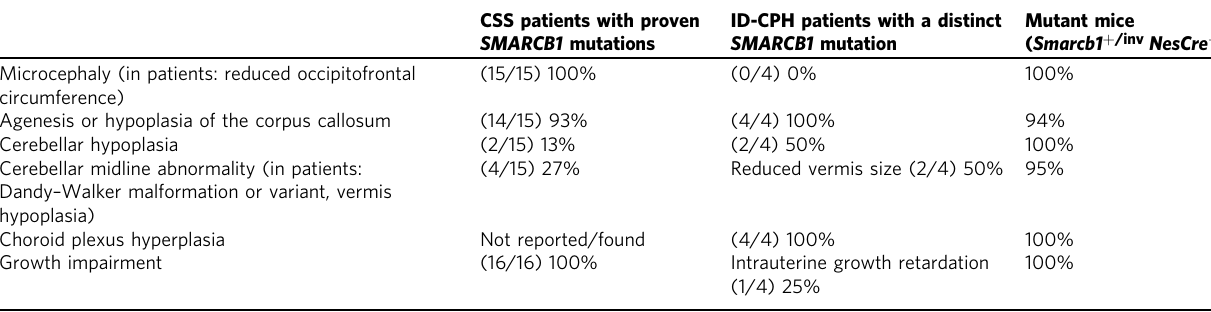
Table 2 Comparison of mutant mice with SMARCB1-related CSS and ID-CPH